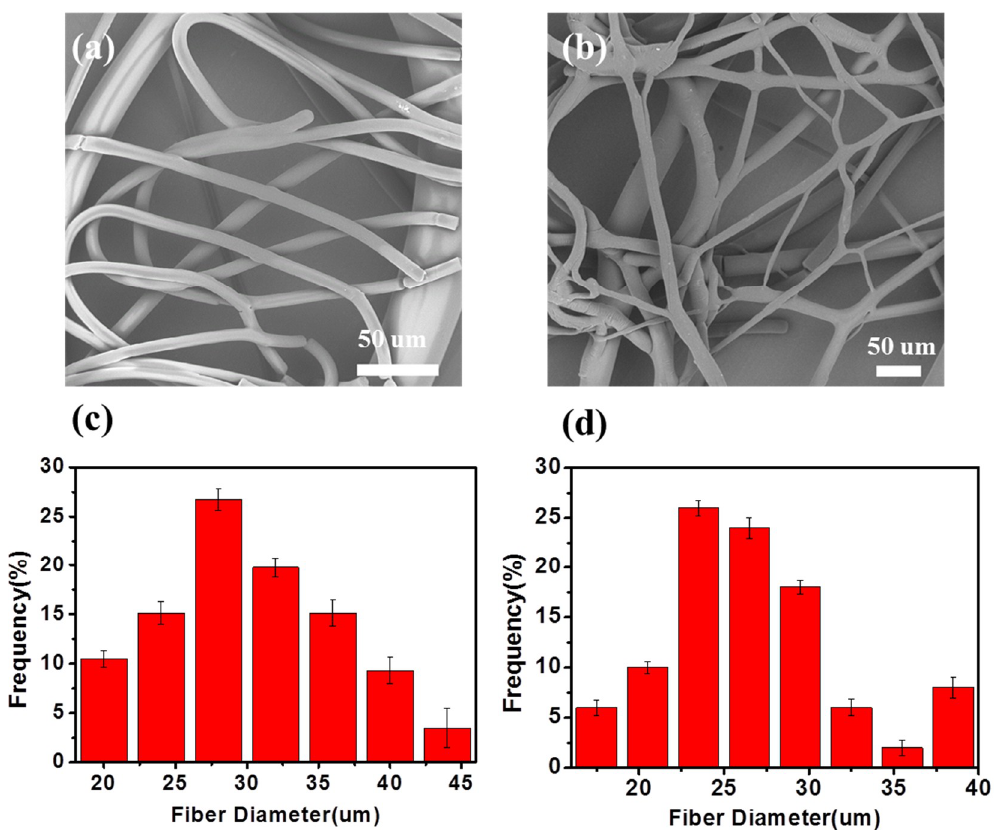
Figure 8. ( a , b ) SEM photograph and ( c , d ) diameter distribution of the melt e-spun PLA fibers.